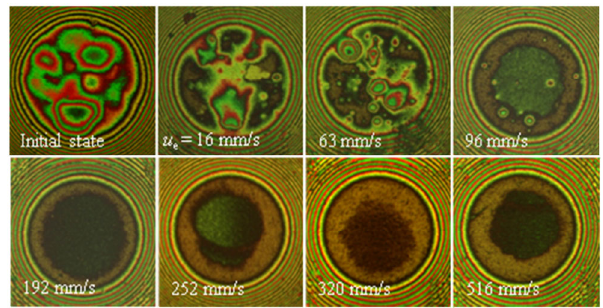
Fig. 10 Initial contacts and worked contacts under static state, Grease